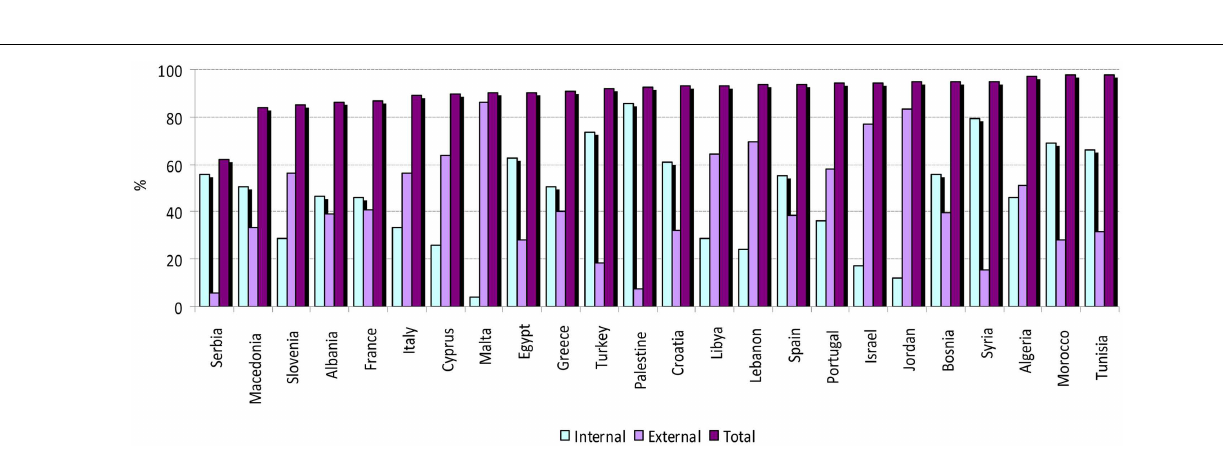
FIGURE 4 |Water footprint of national consumption [Source: adapted from Ref. (47)] . NA, North America; NE, North Europe.